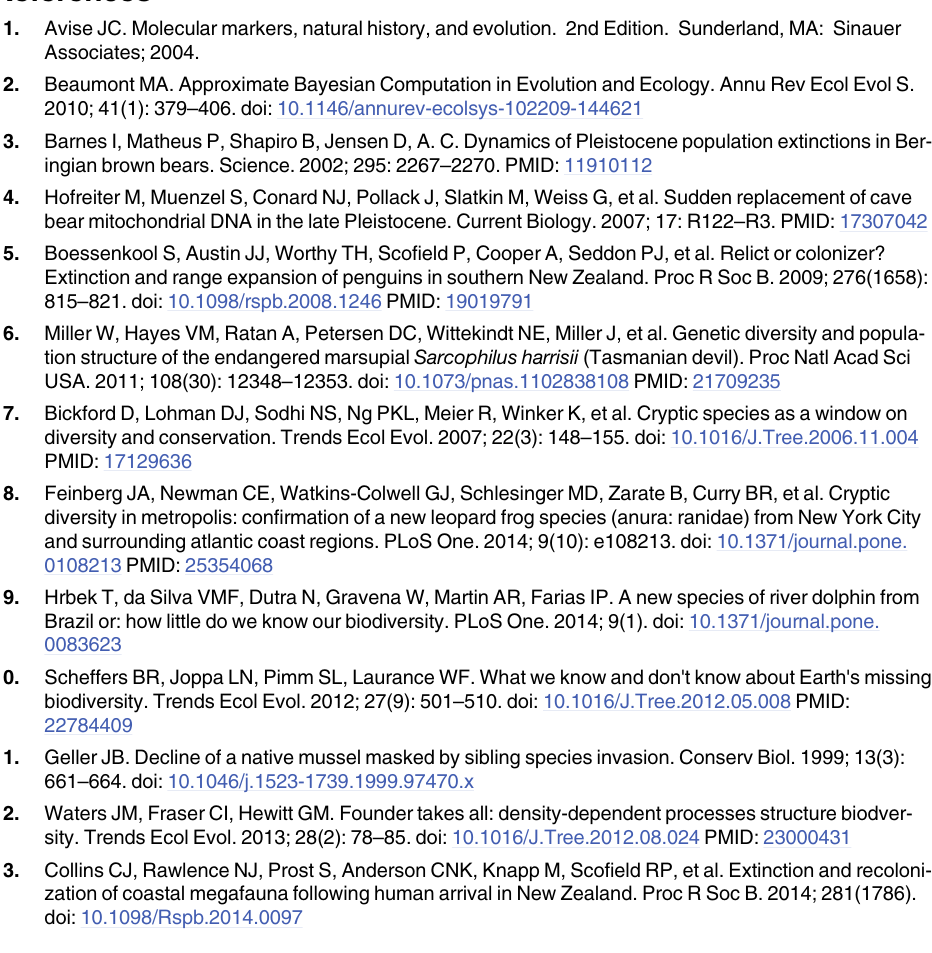
S2 Table. AMOVA table. Assessment of hierarchical genetic variation between regional E . minor groupings based on genotypes from 19 microsatellite loci together with sequences from mtDNA control region. NZ – New Zealand, AUS – Australia. Values that were significantly dif- ferent from zero are indicated by an